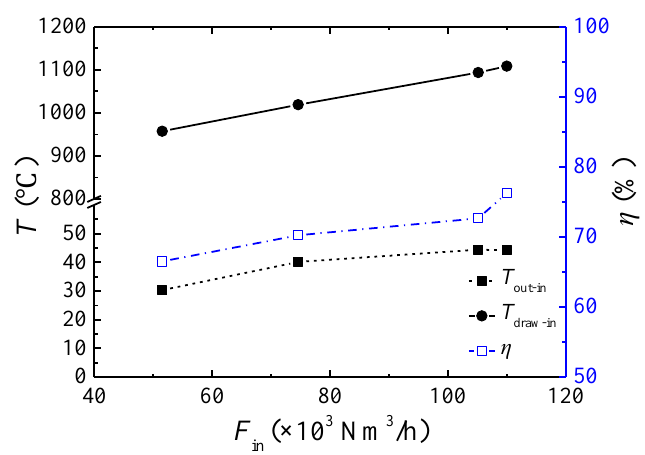
Figure 11. Temperature difference between the hot gas withdrawal flow and inlet gas ( T draw-in ), outlet-inlet gas temperature difference ( T out-in ), and heat recovery efficiency ( η ) for different inlet flow rates ( F in ) at Y CH4,in ≈ 1 vol % and t c = 450 s.